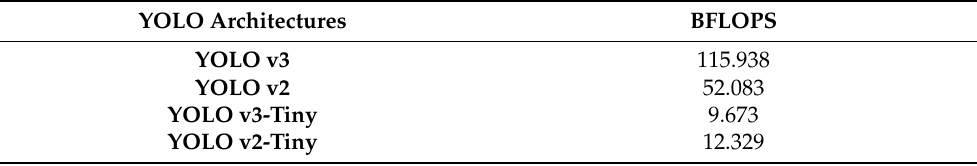
Table 1. Performance of each YOLO architecture.